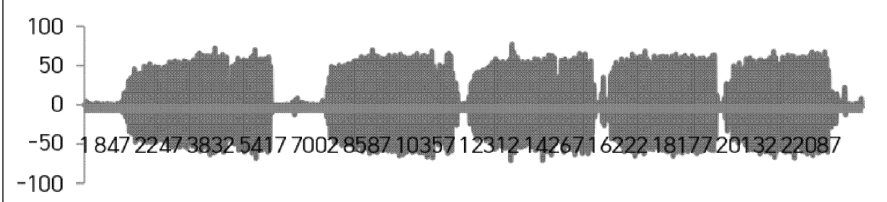
Figure 5. Velocity profile of cutting five separate lines in a piece of